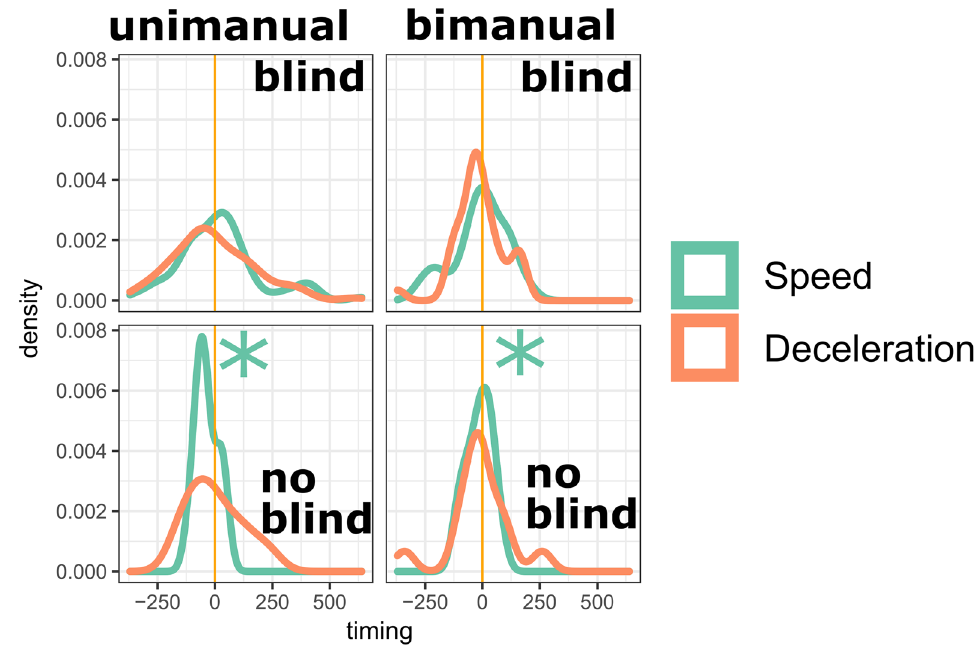
Figure 9. Deceleration versus speed. Note . Timing distributions are shown where more peaked distributions indicate better synchronization. The timings are shown for peak speed versus peak F0 (speed; in orange) and peak deceleration versus peak F0 (deceleration; green). The gestures in the no blind conditions had better synchronization for speed, but this primacy disappeared for the blind condition, providing additional evidence that there is indeed a change in the gesture-speech